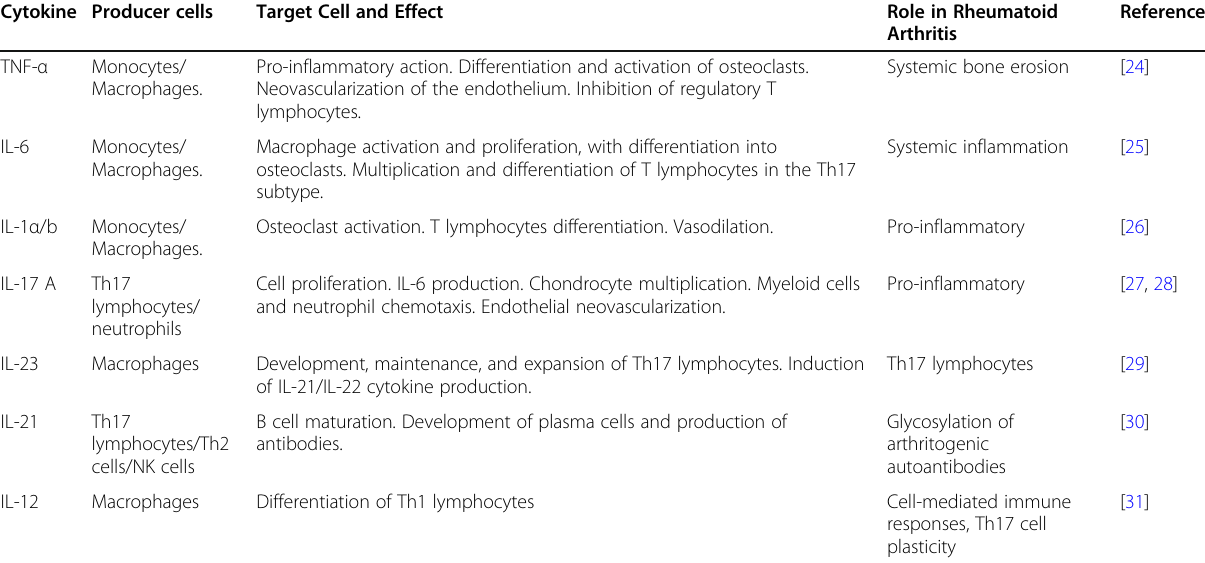
Table 1 Cytokines and their role in the immunopathogenesis of Rheumatoid Arthritis Cytokine Producer cells Target Cell and